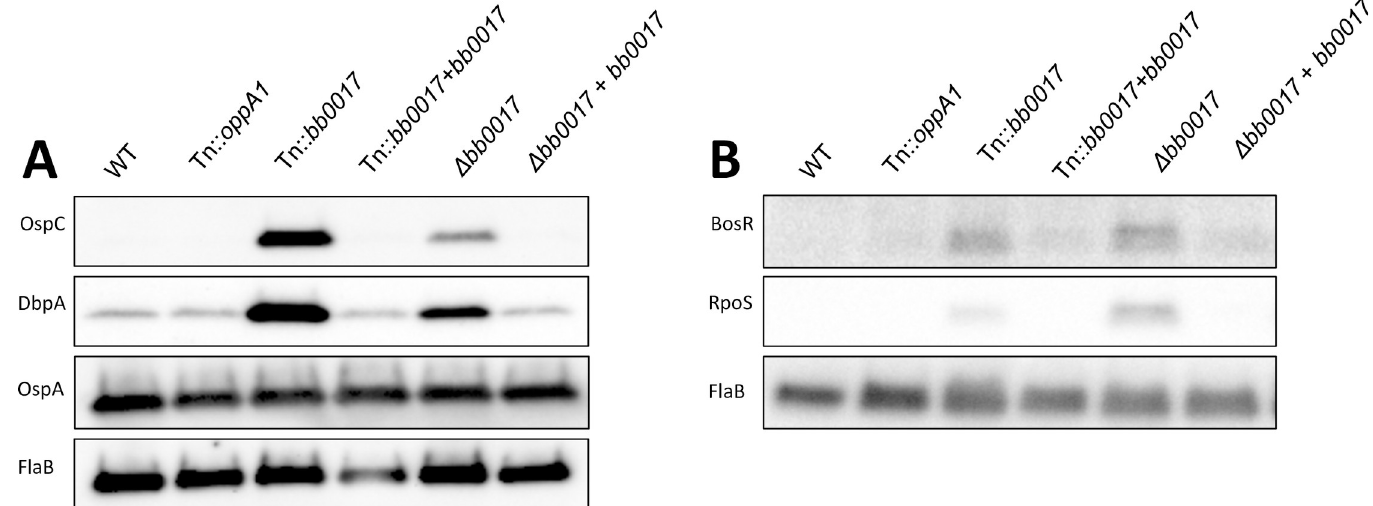
Fig 6. Immunoblot analysis of (A) lipoprotein expression and (B) regulatory protein expression across different B . burgdorferi bb0017 mutant and complemented strains. A Tn:: oppA1 mutant was also included in these experiments as a further control strain. Bacterial cultures were grown at 32˚C with 1% CO2 until early stationary phase. A volume corresponding to 1 × 10 8 bacteria was harvested by centrifugation, cells were washed and lysed, and lysate corresponding to approximately 2 × 10 5 cells was subjected to immunoblot analysis. FlaB levels were analyzed as a loading control.